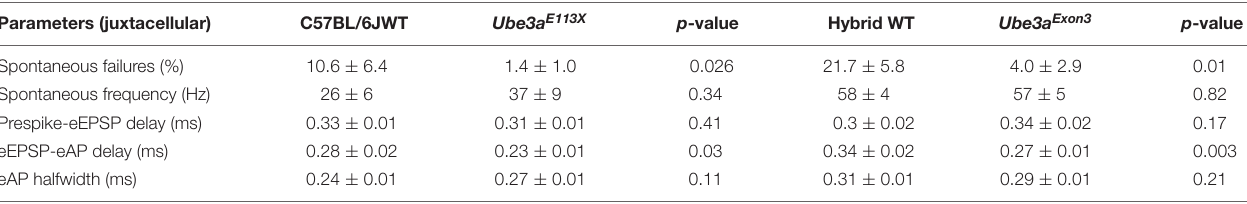
TABLE 1 | Comparison of spontaneous firing and complex waveforms between WT and Ube3a mice. Parameters